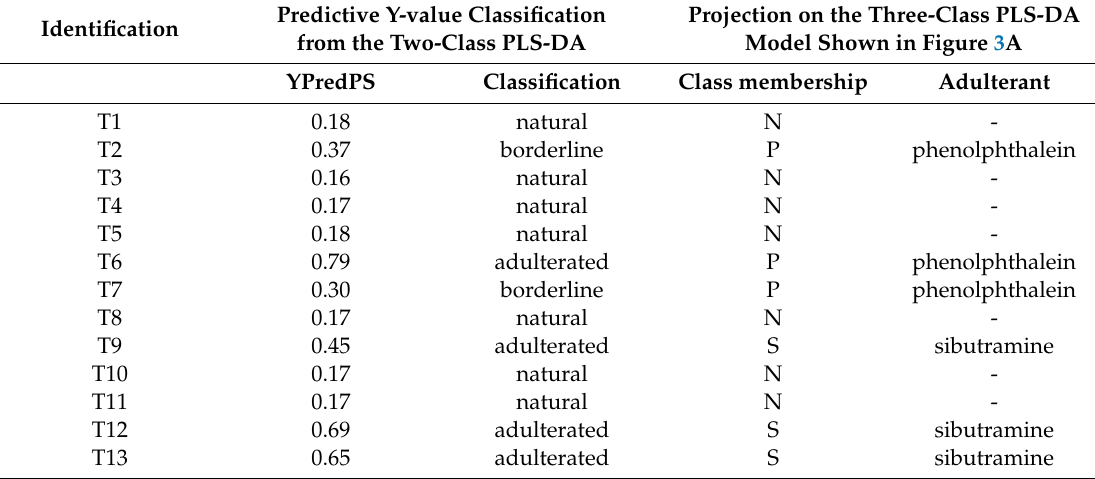
Table 1. Classification list showing predicted Y-values (YPredPS) for test samples (T) based on the two-class PLS-DA model built with LF 1 H NMR data and completed by the visual observation of the projection of the samples on the three-class PLS-DA model shown in Figure